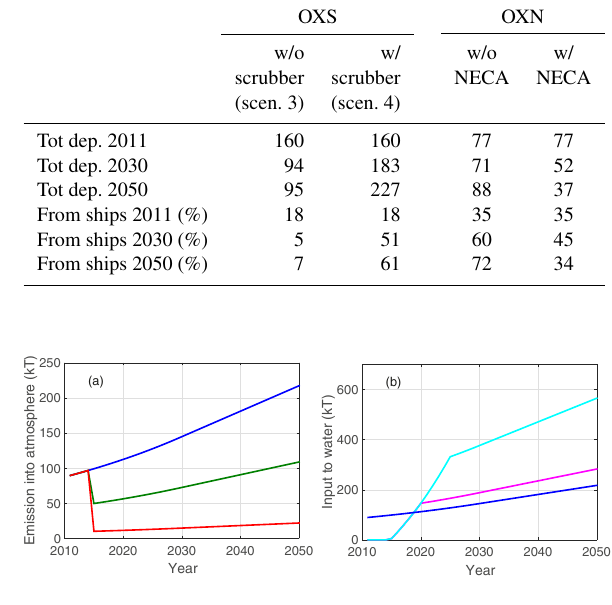
Figure 5. (a) Emissions of oxidized sulfur into the atmosphere in the Baltic Sea area (kt) from 2010 to 2050 for scenarios 1 to 3. The blue line corresponds with scenario 1, the green line with scenario 2, and the red line with scenario 3. (b) Emission directly into the water of the Baltic Sea (kt) for scenarios 1, 4, and 5 in 2010 to 2050. The magenta line corresponds with scenario 4 and the cyan line with scenario 5. For comparison, the blue line shows the atmospheric deposition from scenario 1.